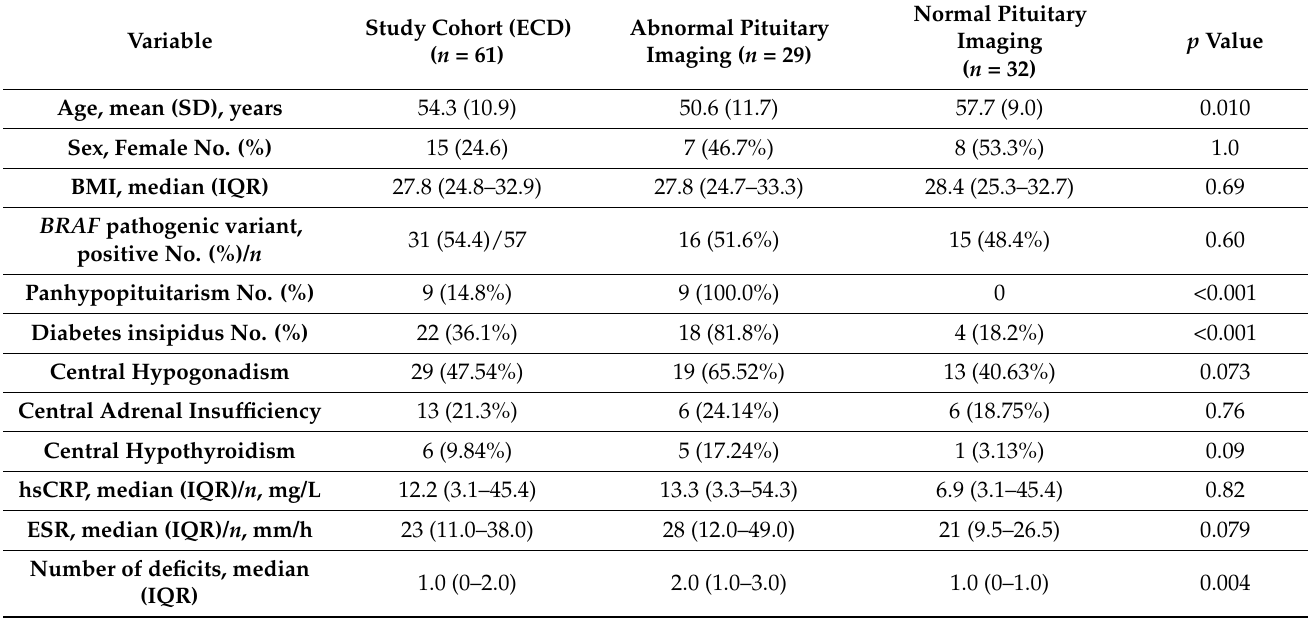
Table 1. Comparison of abnormal and normal pituitary imaging of ECD subjects. p values listed for normal vs. abnormal pituitary